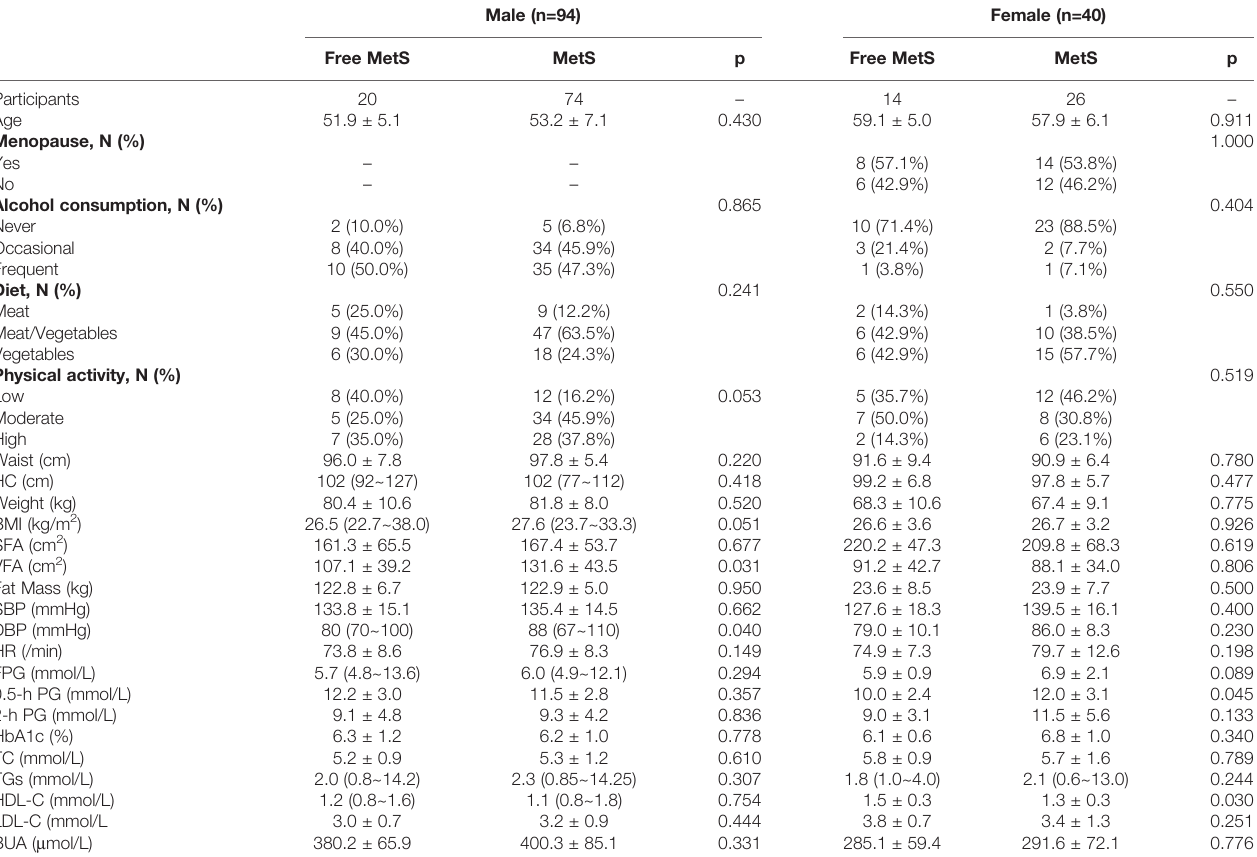
TABLE 4 | Outcomes of patients with metabolic syndrome during 1.5 years of